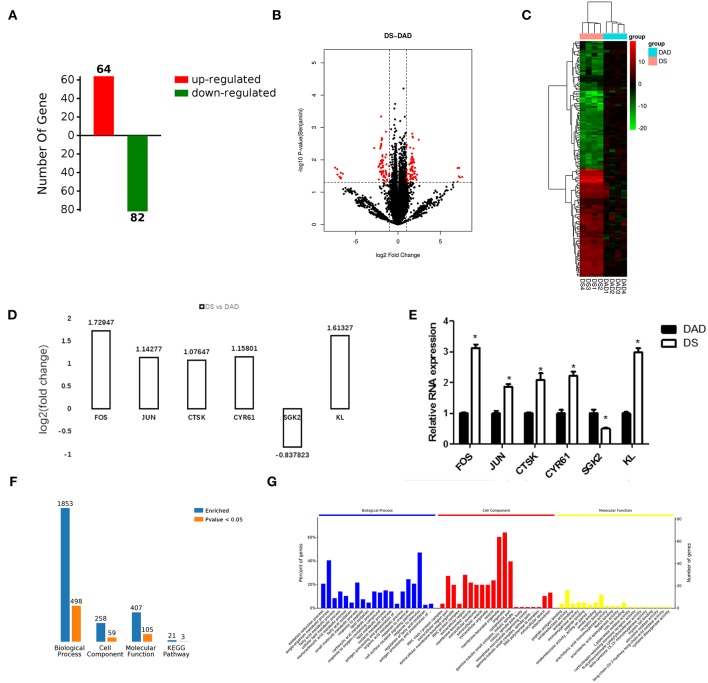
Effects of dietary daidzein supplementation of hens on differential gene expression and functional enrichment. (A) Number of differentially expressed genes (DEGs) (up/downregulated) in hens after daidzein supplementation at 20 mg/kg. (B) Heatmap of expression of DEGs in samples. DAD, daidzein-deficient group; DS, daidzein-supplemented group. DAD group samples: DAD1-4; DS group samples: DS1-4. (C) Volcano map of the expression of DEGs. (D) Fold change based on transcriptome results for six DEGs. (E) Relative RNA expression of the six genes by qRT-PCR. (F) Number of DEGs enriched in GOs and pathways. (G) Top 20 significantly enriched biological processes, cell components, and molecular functions.